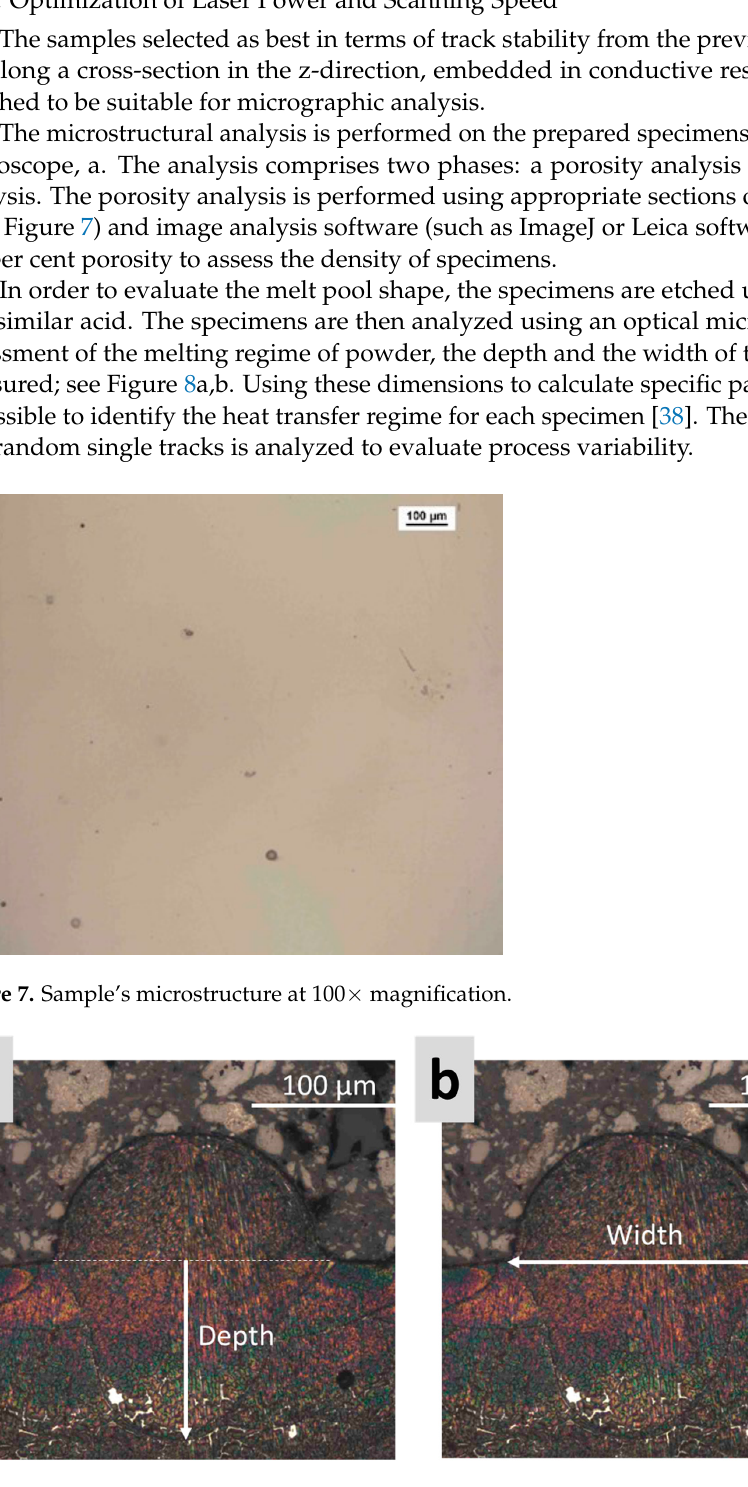
Figure 8. Melt pool’s measurement: ( a ) depth; ( b )